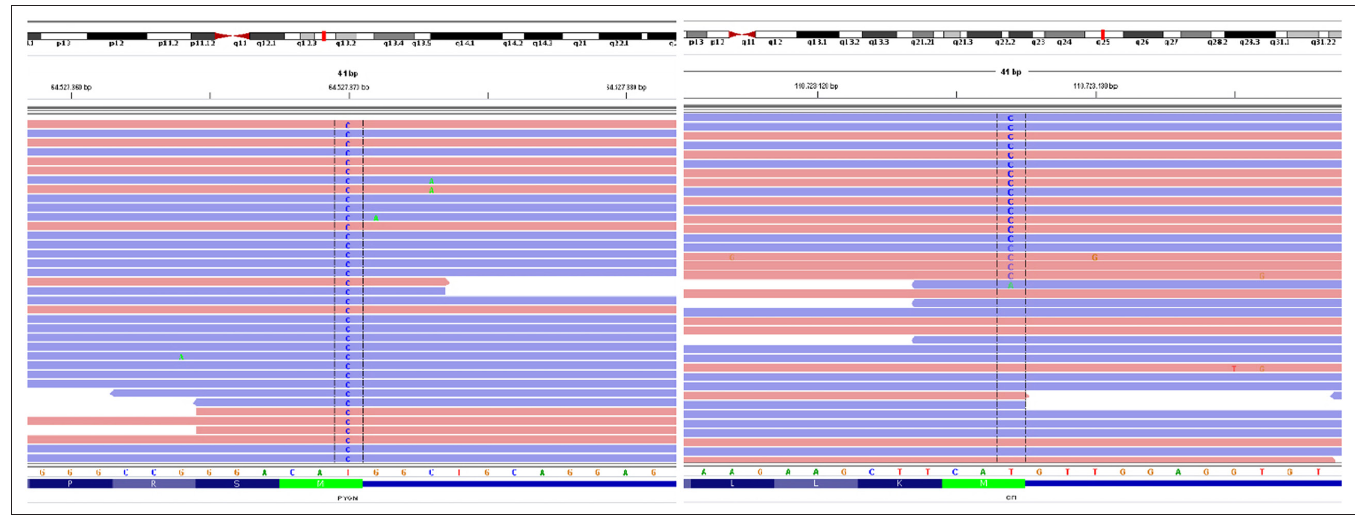
Figure 1. PYGM: c.1A > G (p.M1V) homozygous mutation on next-generation sequencing. CFI: c.1A > G (p.M1V) heterozygous mutation on next-generation sequencing. Both genes are located on the reverse